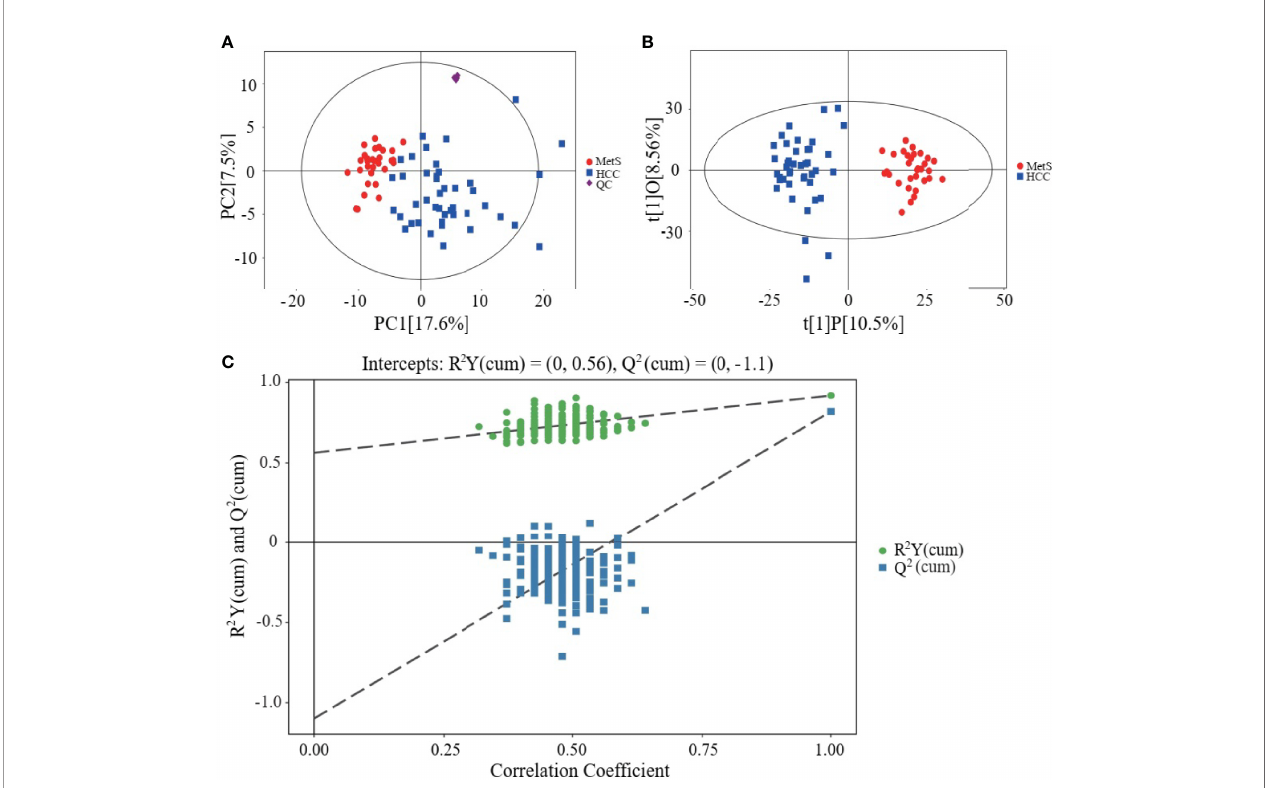
FIGURE 1 | Metabolic pro fi ling of serum samples from patients with MetS and MetS(+) HCC. (A) Score plot of principal component analysis (PCA) based on the combinational data of ESI+ and ESI- modes. (B) Score plot of orthogonal projections to latent structures-discriminate analysis (OPLS-DA). (C) Statistical validation of the OPLS-DA model in 200 random permutation